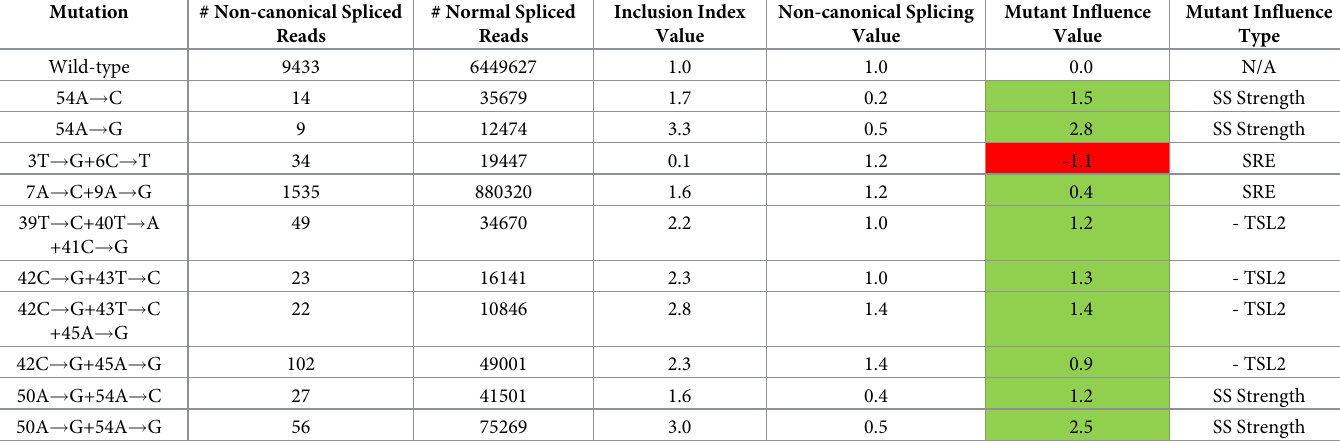
Table 4. Mutant influence on splicing fidelity—Non-canonical 3’ splice site AG/CCTCTGGN 10 ... CAG|GAA .